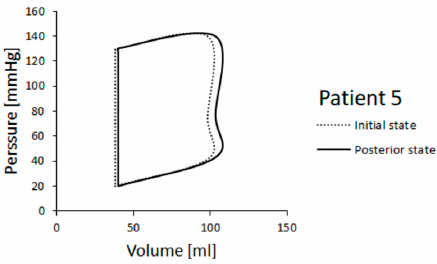
Figure 13. P-V diagram for patient 5.